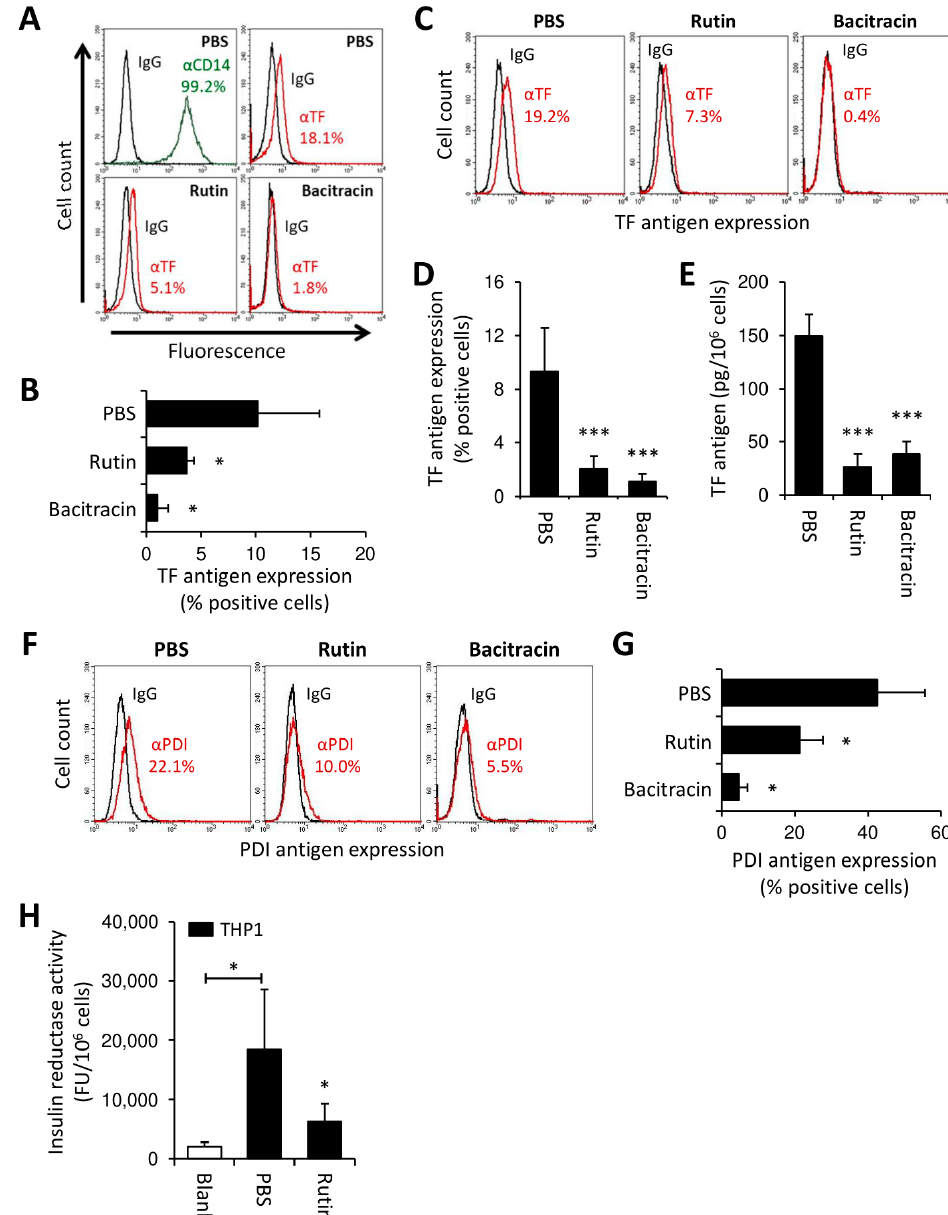
Figure 3. Rutin and bacitracin downregulate PDI and TF in monocytes and THP1 cells. ( A , B ) CD14-positive monocytes were isolated from PBMCs and maintained in suspension culture for 24 h at 37 ◦ C in the presence of PBS (control), rutin (100 µ M) or bacitracin (5 mM). Cells were subsequently analyzed for TF antigen by flow cytometry (mean ± SD, n = 4). ( C – H ) THP1 cells were incubated with PBS, rutin (100 µ M) or bacitracin (5 mM) for 24 h at 37 ◦ C, washed and analyzed for TF antigen by flow cytometry (mean ± SD, n = 11) ( C , D ), total cellular TF antigen by ELISA (mean ± SD, n = 3) ( E ) and for PDI antigen by flow cytometry (mean ± SD, n = 3) ( F , G ). In addition, rutin-treated THP1 cells were assessed for insulin reductase activity (mean ± SD, n = 6) ( H ). Representative histograms are shown in panels ( A , C , F ). Corresponding summary statistics are shown in panels ( B , D ) and ( G ). p -values are according to Tukey’s post-hoc test (*, p < 0.05; ***, p <